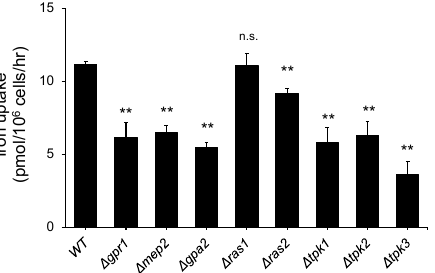
Figure 1. Deletion of the genes involved in glucose and nitrogen metabolism resulted in a decrease in iron uptake. Each indicated deletion mutant of S. cerevisiae was cultured in YPD medium until mid-log phase, and an iron uptake assay was performed as described in the Materials and Methods section. The assay was performed in triplicate. n.s., not significant; **: p < 0.01 indicates a significant difference compared to wild type.